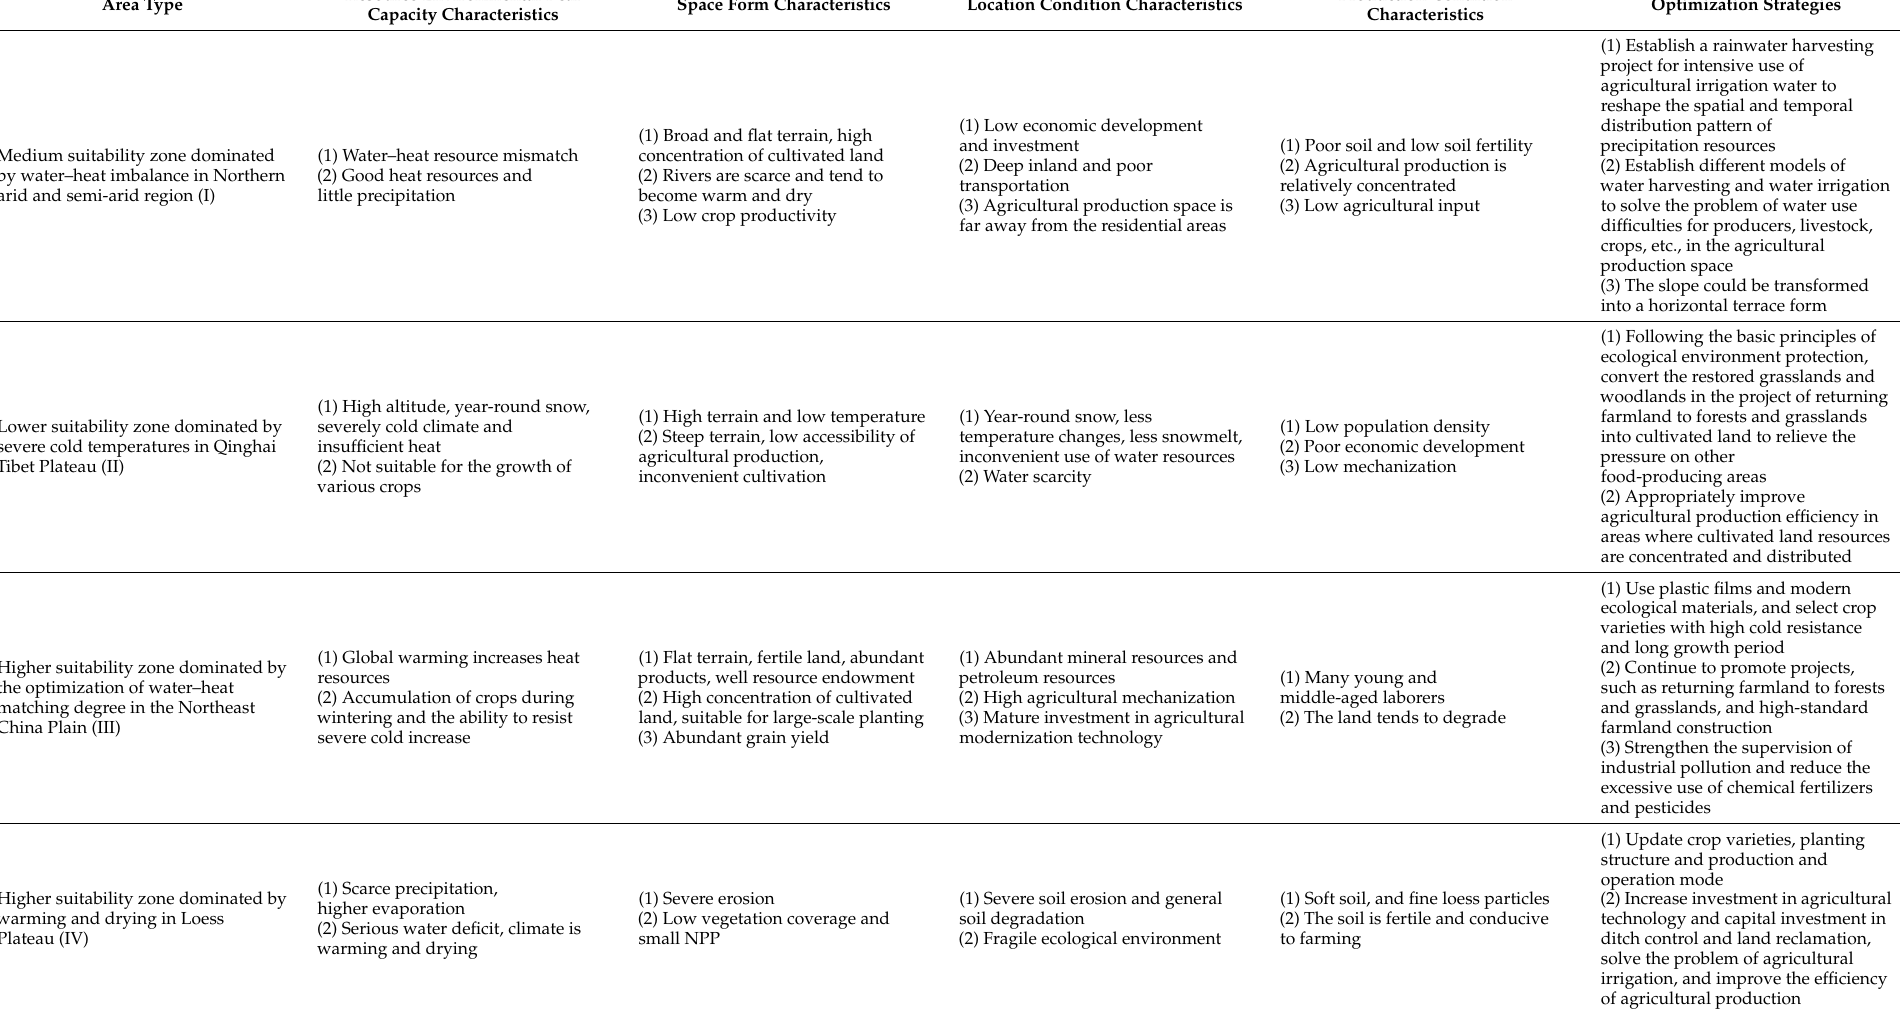
Table 6. Characteristics of regional patterns and optimization strategies of China’s agricultural production